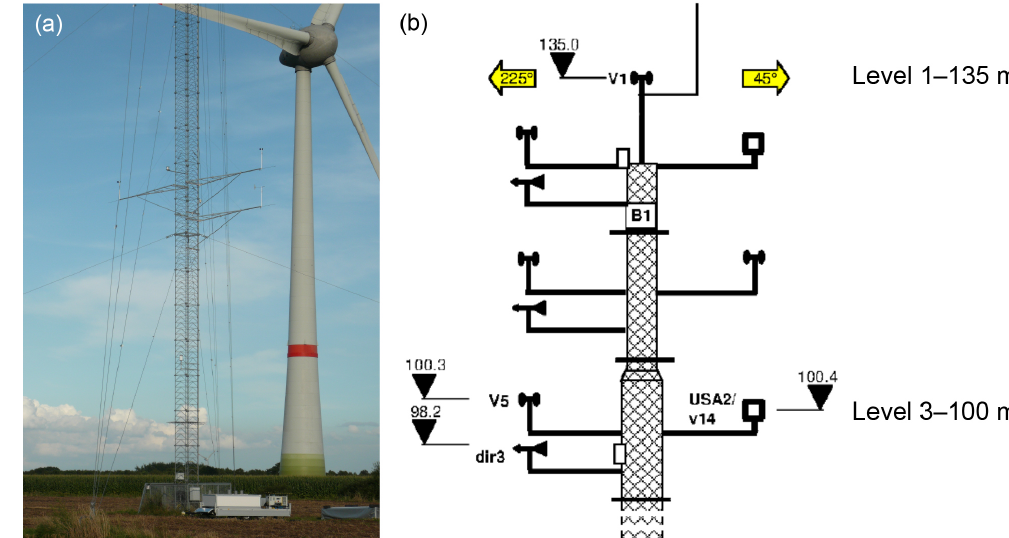
Figure 5. (a) Wind energy test field in Aurich (Germany) with wind met mast, wind turbine and PTB lidar trailer. (b) Outline of the three upper measurement levels of the 135m wind met mast.